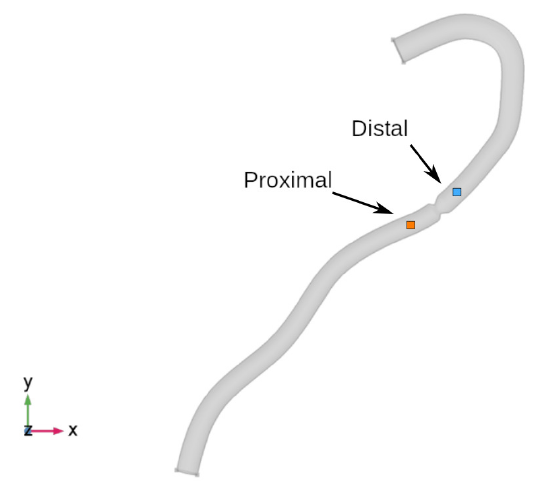
Figure 1. Proximal and distal virtual measurement points inside the vessel model reconstructed in Comsol.